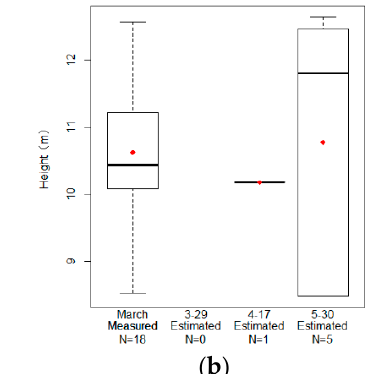
Figure 7. Box-and-whisker plot of measured and estimated tree heights at three dates for deciduous species TM ( a ) and FV ( b ).